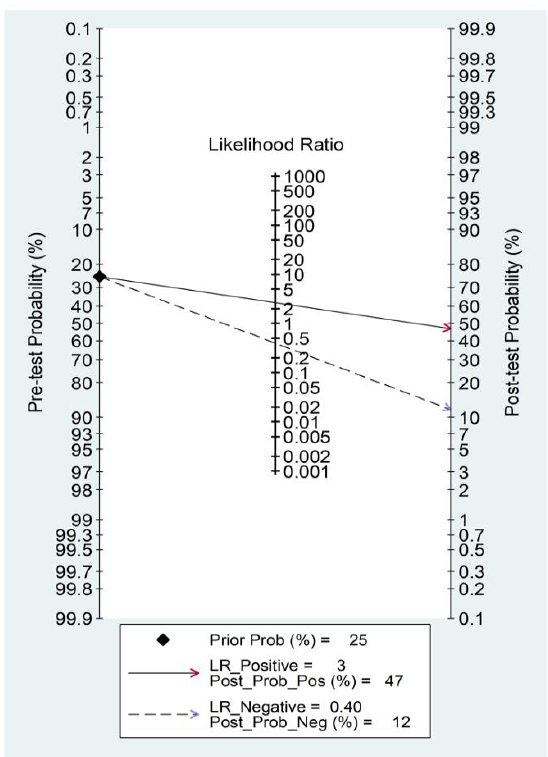
Figure 17. Fagan’s nomogram for the neutrophil -to-lymphocyte ratio in adverse outcome predic-